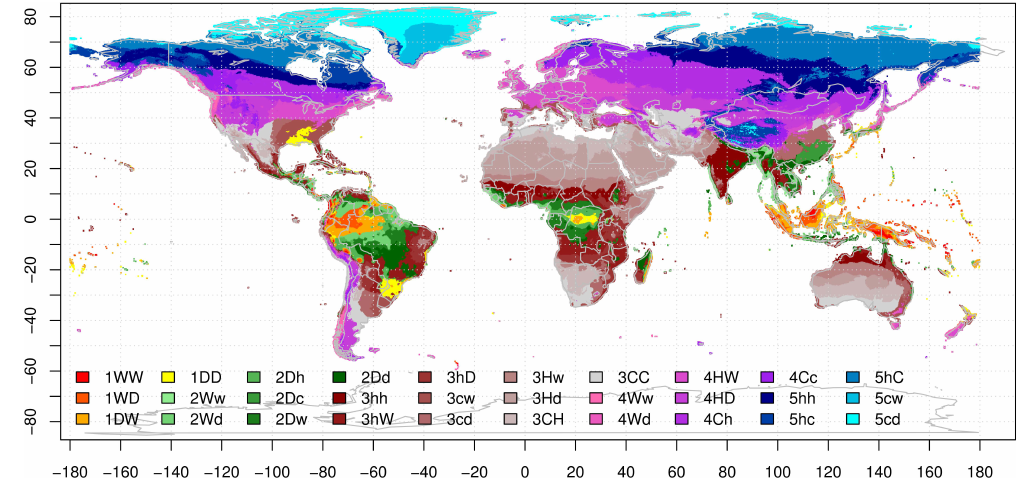
Fig. 2. Global map of MRT climate classification. The naming convention is given in Fig. 1.